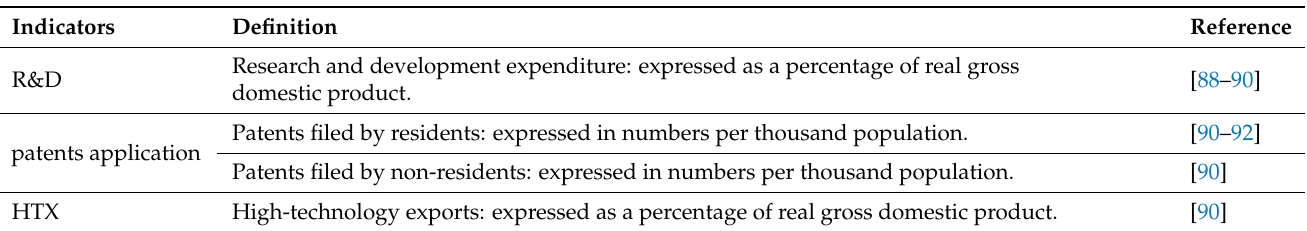
Table 2. Definition of innovation output with reference.